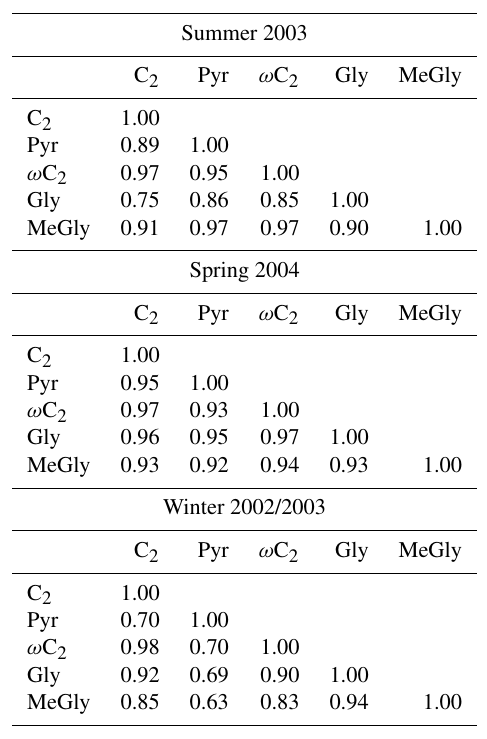
Table 2. Correlation coefficients ( r 2 ) among oxalic acid (C 2 ), pyru- vic acid (Pyr), glyoxylic acid ( ω C 2 ), glyoxal (Gly) and methylgly- oxal (MeGly) detected in aerosol samples from aircraft campaigns during summer 2003 ( n = 14), spring 2004 ( n = 16) and winter 2002/2003 ( n = 18) over China. See Table 1 for abbreviations.